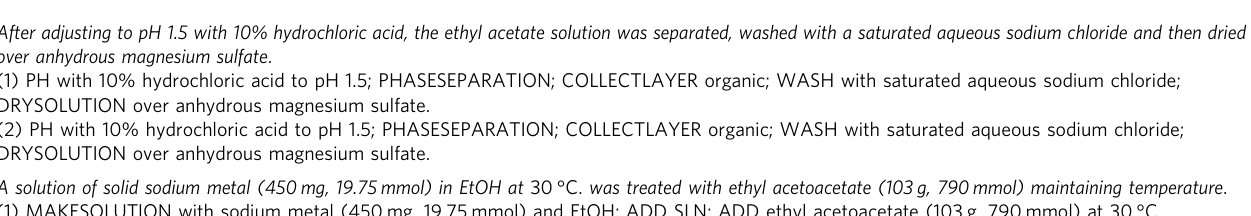
Table 4 Example of extracted action sequences.